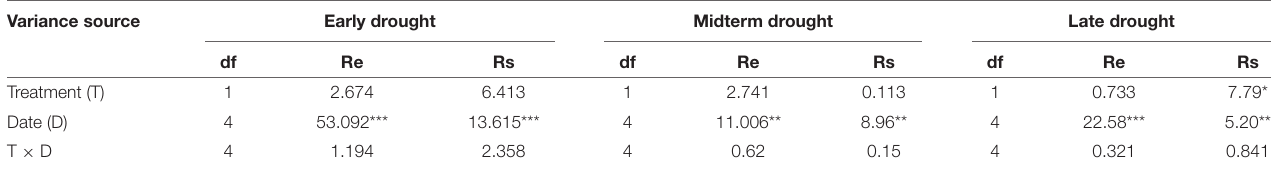
( Figure 5 ): SWC, pH, SOC, DOC, MBC, BX, BG, and PPO ( χ 2 = 7.992, d f = 11, P = 0.714, CFI = 1.000, RMSEA =